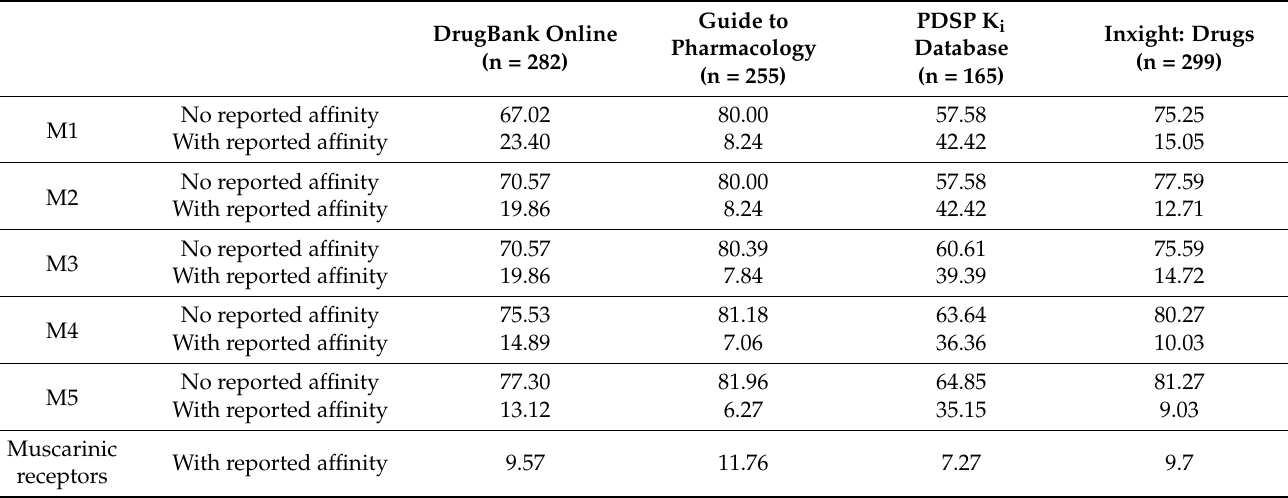
Table 1. Percentage of drugs identified by each database regarding their affinity for each of the muscarinic receptor subtypes. DrugBank Online (n = 282)